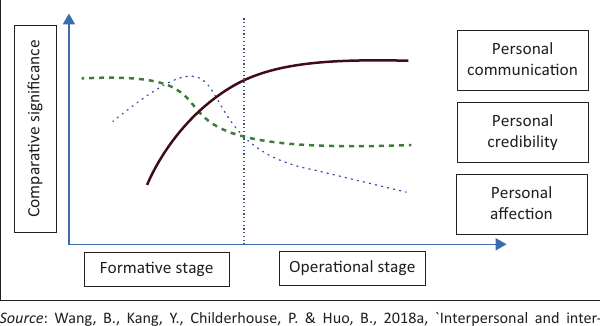
FIGURE 1: Personal affection, personal credibility and personal communication in supply chain integration